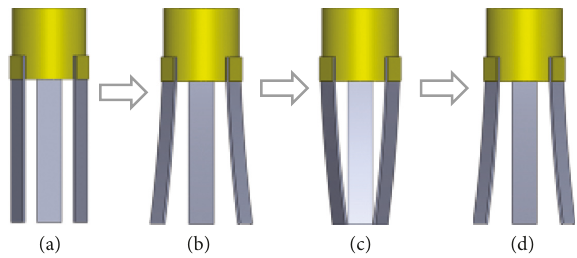
Figure 3: Motion cycle of the soft robot manipulator to grab an